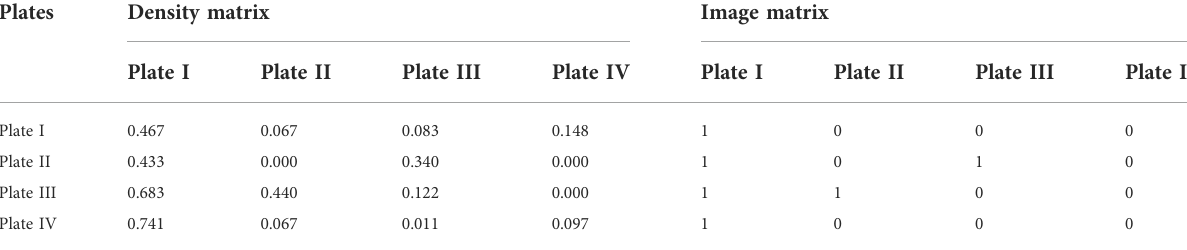
TABLE 8 Density matrix and like matrix of spatially correlated panels of carbon emission ef fi ciency in China ’ s logistics industry. Plates